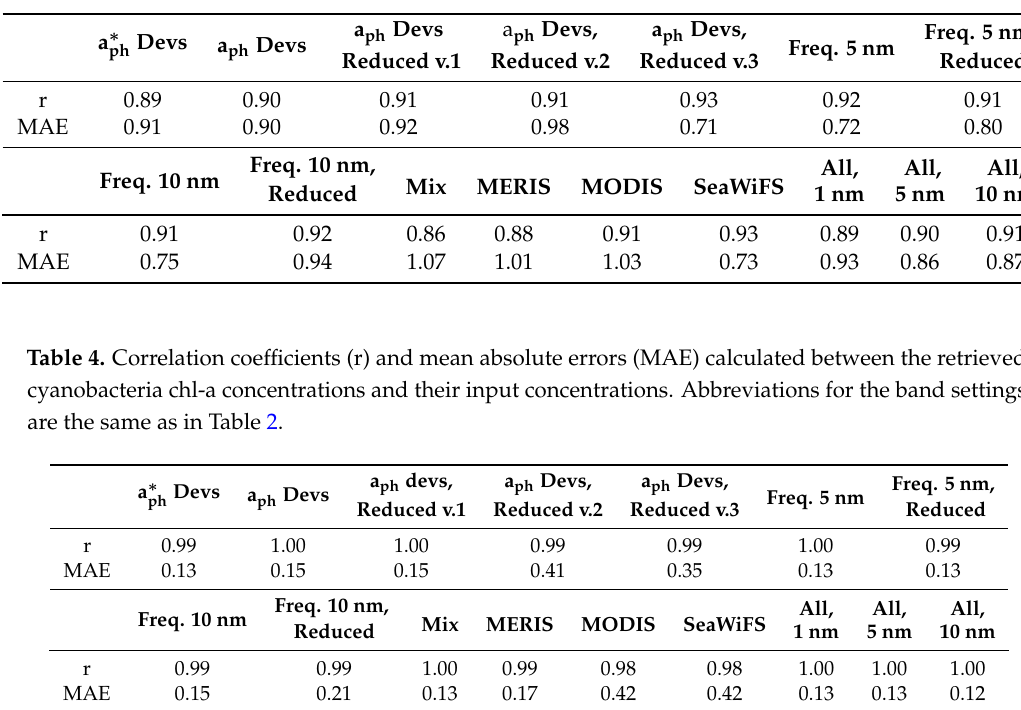
Table 3. Correlation coefficients (r) and mean absolute errors (MAE) calculated between the retrieved coccolithophores chl-a concentrations and their input concentrations. Abbreviations for the band settings are the same as in Table 2.